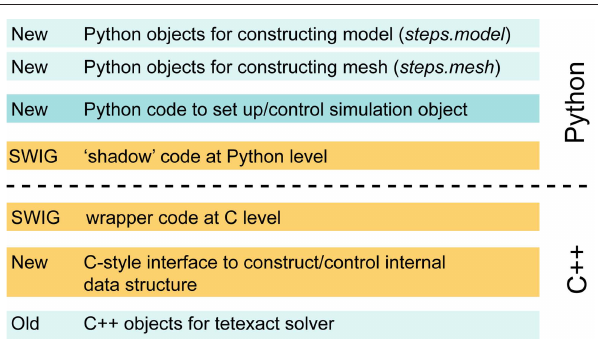
FIGURE 4 | Layered view of STEPS code after exposing it to Python with